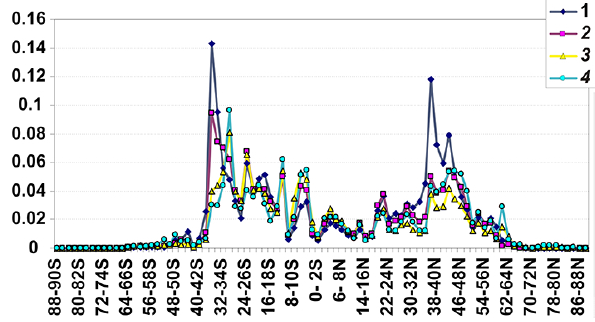
Fig. 3. Four latitudinal distributions of event relative density ( ˆ Np i,k ) for four magnitude ranges (size of the latitude belt – two degrees): 1 for 4 . 0 ≤ M < 4 . 5, 2 for 4 . 5 ≤ M < 5 . 0, 3 for 5 . 0 ≤ M < 5 . 5, and 4 for 5 . 5 ≤ M < 6 .